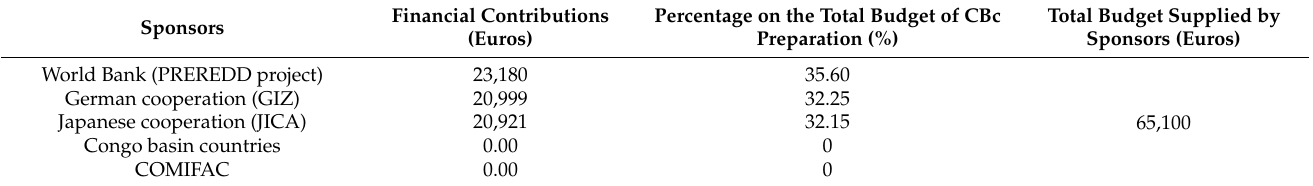
Table 3. Contribution of cooperation agencies to the preparation of Congo Basin countries for climate change CoP 23. Financial Contributions Percentage on the Total Budget of CBc Total Budget Supplied by Sponsors (Euros) Preparation (%) Sponsors (Euros) World Bank (PREREDD